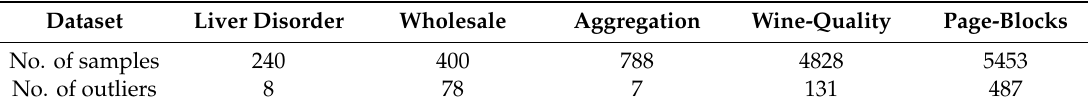
Table 2. The summary of 5 real-world datasets.